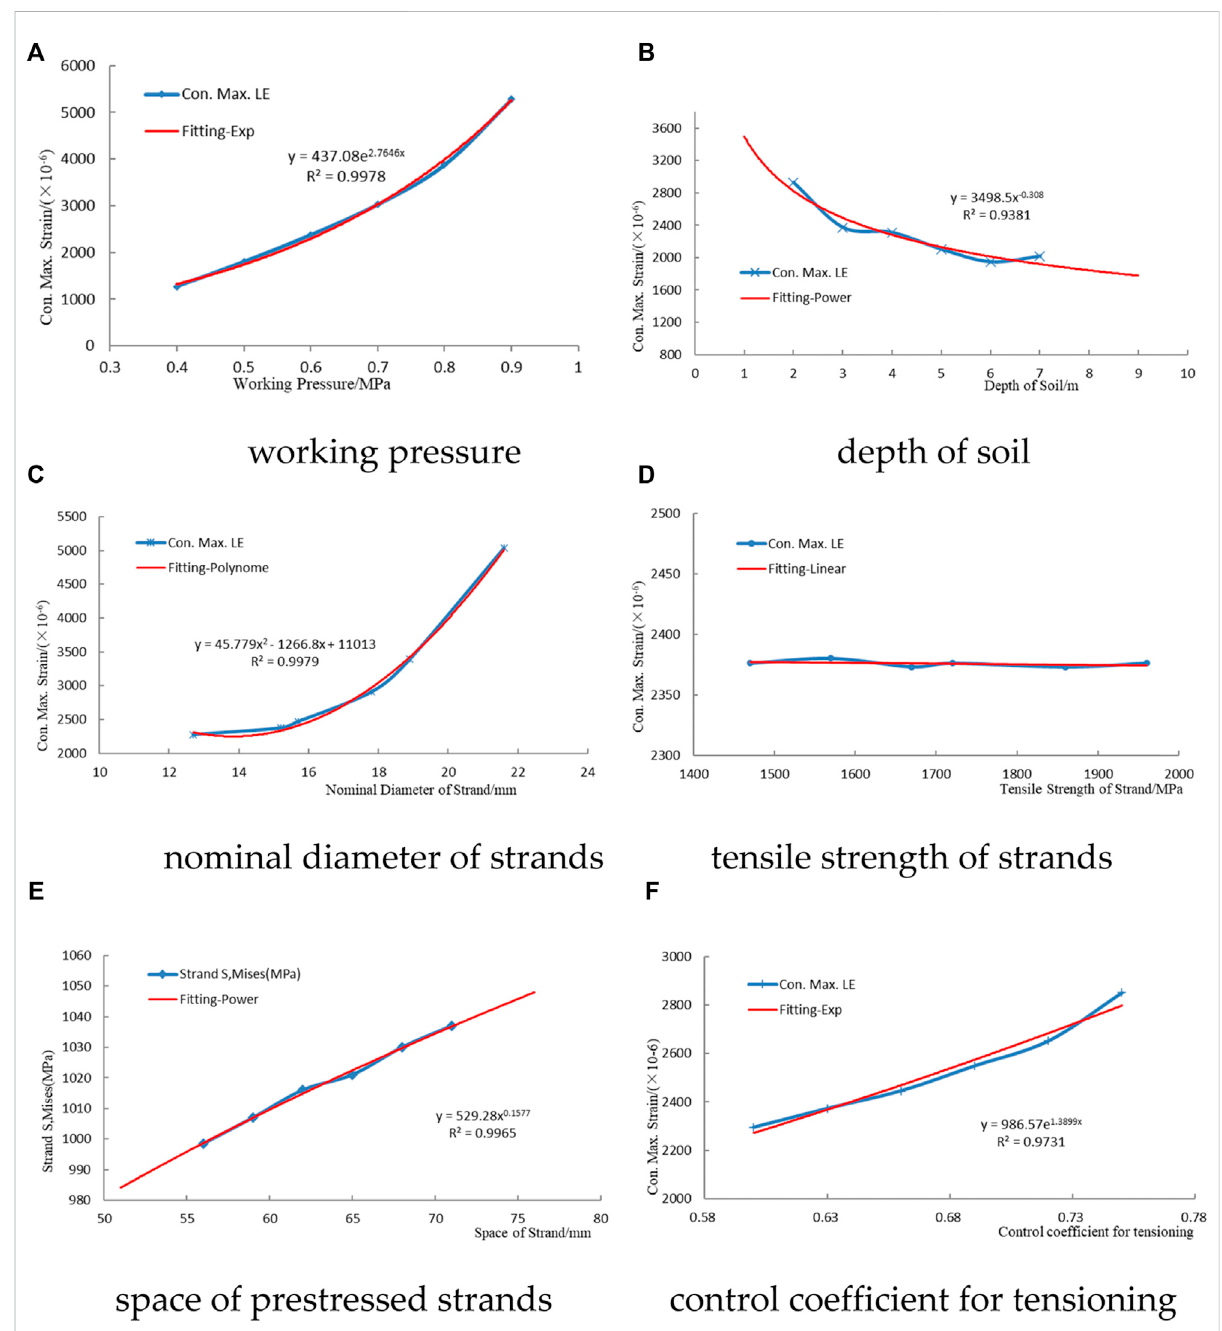
FIGURE 21 Sensitivity analysis of the working pressure. (A) Working pressure, (B) soil depth, (C) nominal diameter of the strands, (D) tensile strength of the strands, (E) space of prestressed strands, and (F) control coef fi cient for